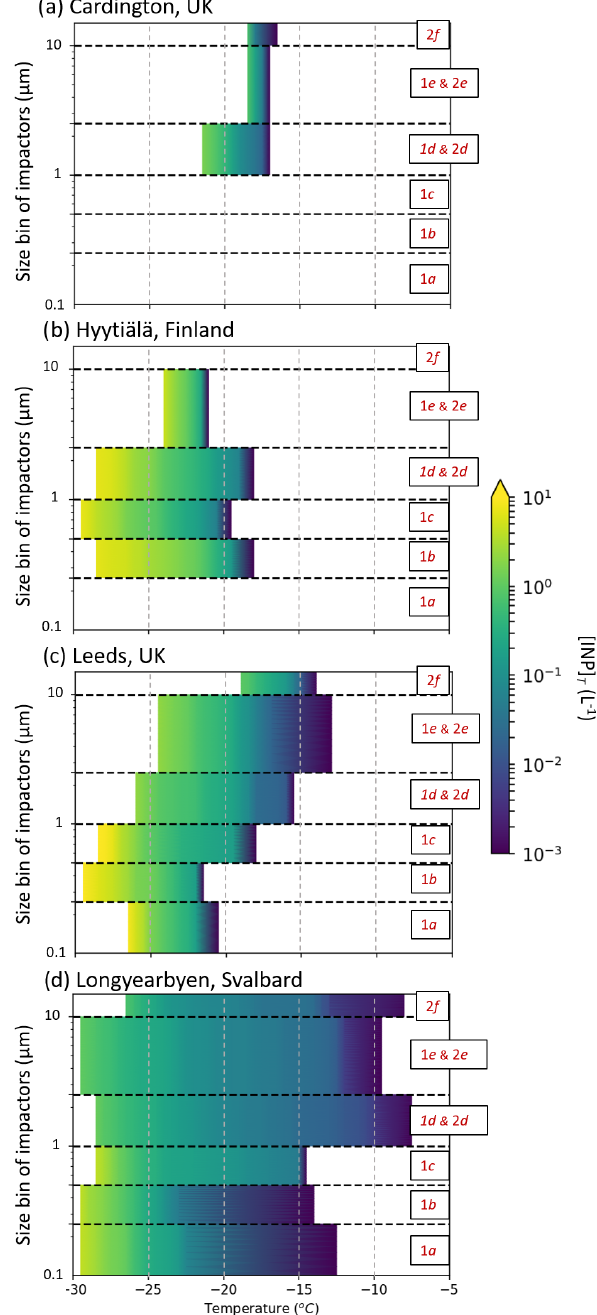
Figure 9. Size-resolved ice-nucleating particle concentrations (sr[INP] T ) for the four test sites: (a) Cardington (UK), (b) Hyytiälä (Finland), (c) Leeds (UK), and (d) Longyearbyen (Svalbard). The colour bars indicate the INP concentration. The dotted lines on the y axis indicate the size cuts of the impactors. The data from Fig. 8 are presented here in an alternative format, which has the advantage of more clearly and concisely displaying the features of the INP spectrum in each size bin than the plots in Fig.